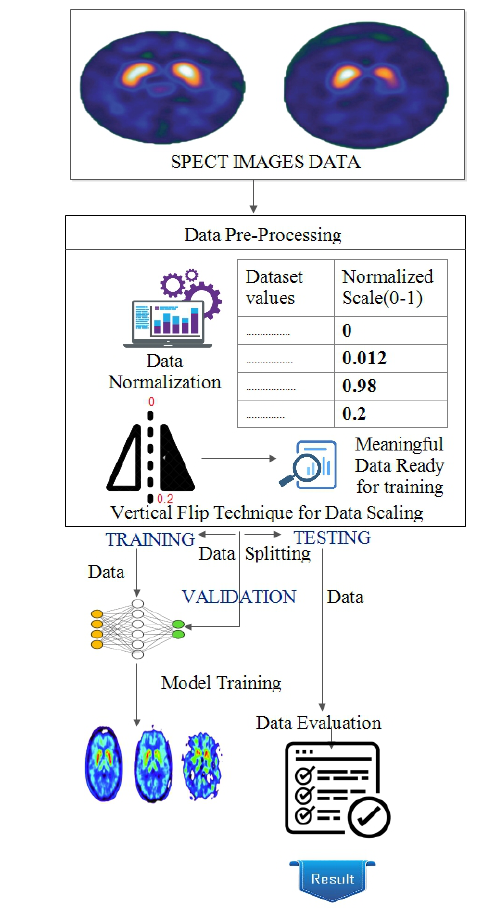
Figure 2. System